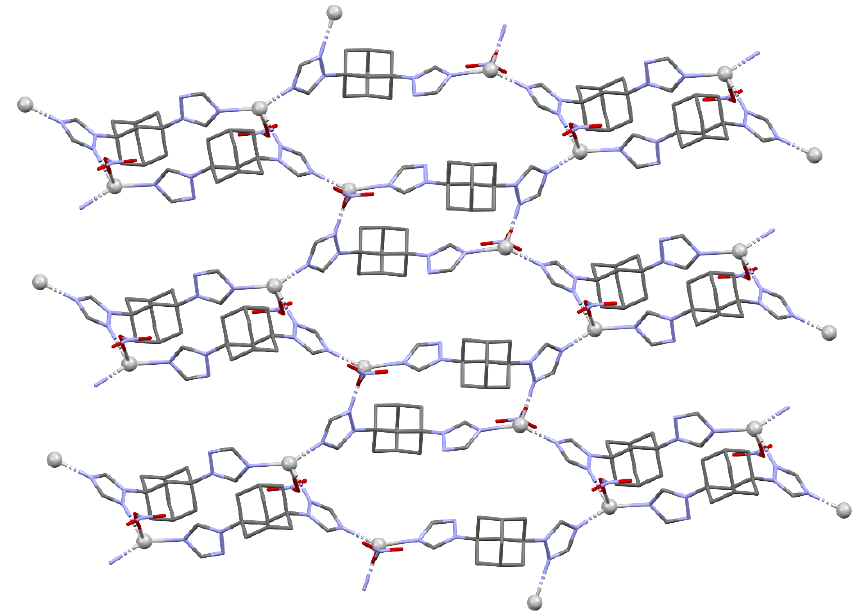
Figure 2. Layer of coordination polymer 1 with 18- and 30-membered metallocycles. Hydrogen atoms are omitted for clarity. Atom legend: Ag—gray balls; C—dark gray dots; N—blue dots; O—red dots.